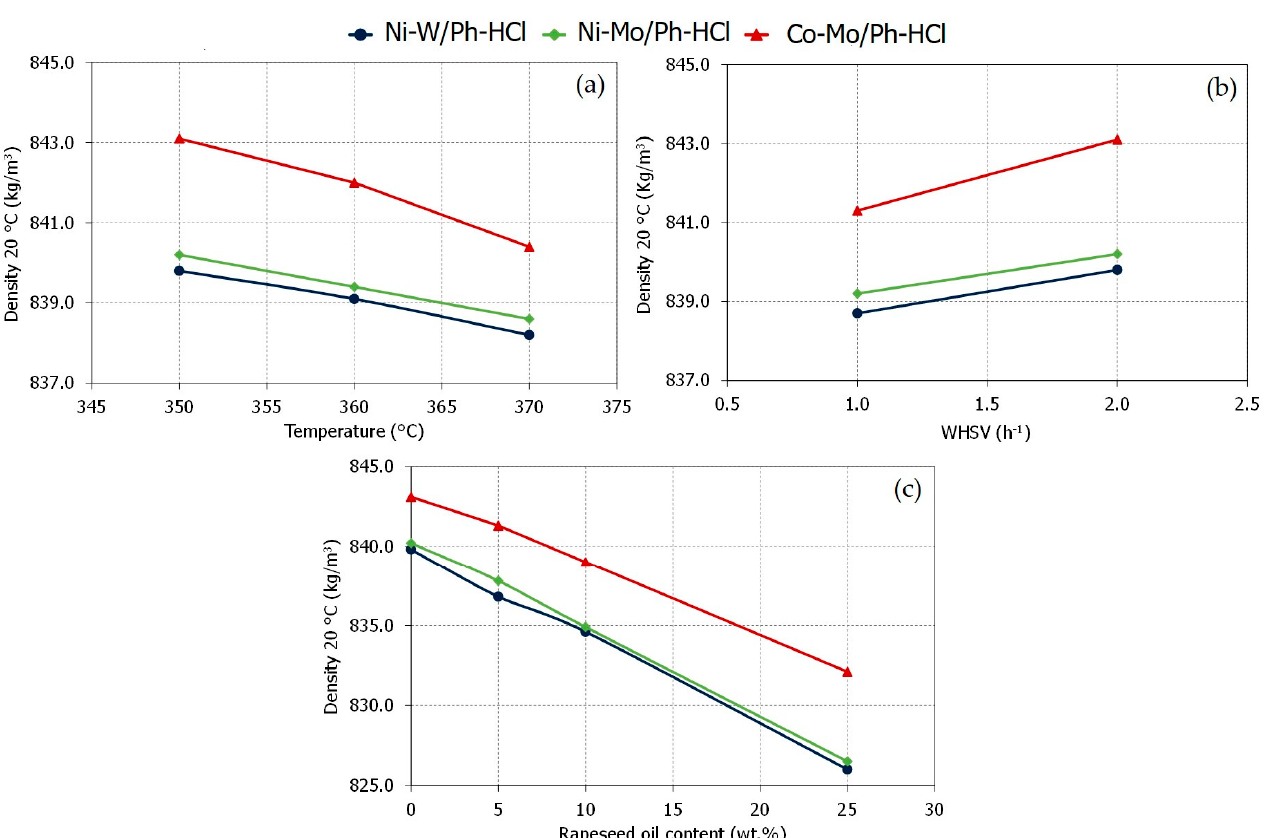
Figure 4. Density of hydrotreated gas oil produced during AGO processing (( a ): 350–370 °C, WHSV 2 h − 1 , 5.5 MPa; ( b ): 350 °C, WHSV 1-2 h − 1 , 5.5 MPa) and AGO/RSO co-processing (( c ): 350°C, WHSV 2 h − 1 , 5.5 MPa, RSO 0, 5, 10 and 25 wt.%). (Note: The 0 wt.% of RSO corresponds to 100% AGO).